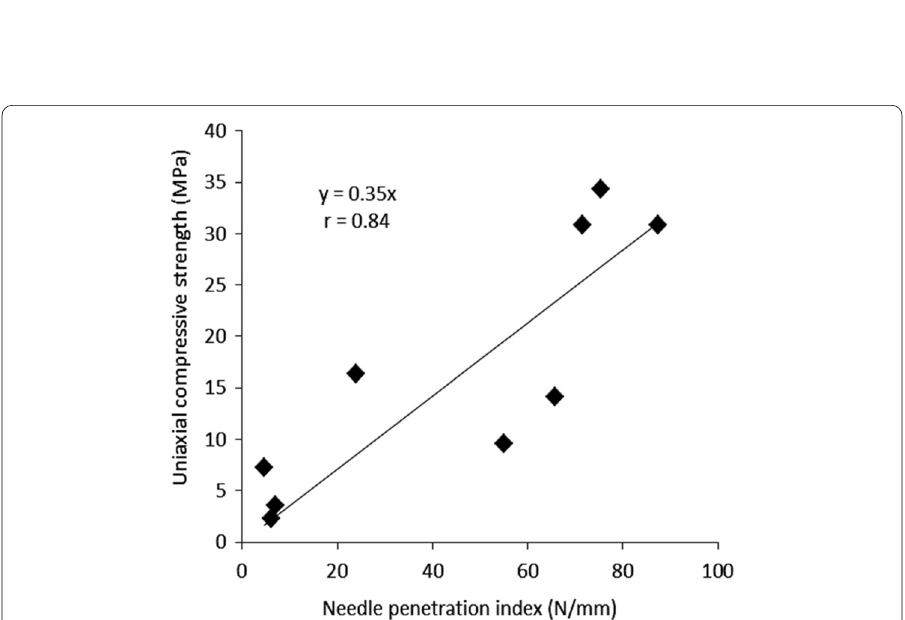
Fig. 5 Correlation between the UCS and the